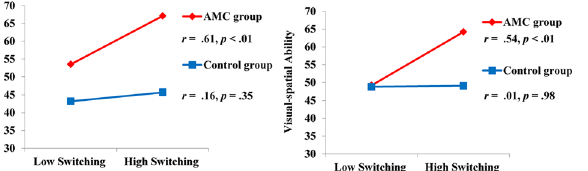
Fig 3. Interaction between AMC training and task switching ability measured by RT switch cost in grade 4 to predict math abilities. The criterion on the y-axis was plotted against two levels of the task switching ability: low switching ability (1 SD above the mean of RT switch cost) and high switching ability (1 SD below the mean of RT switch cost). Plotted regression lines represented the correlations in AMC (red line) and control groups (blue line). Each line represented partial correlations between task switching and math abilities for each group after controlling for pre-training intelligence.